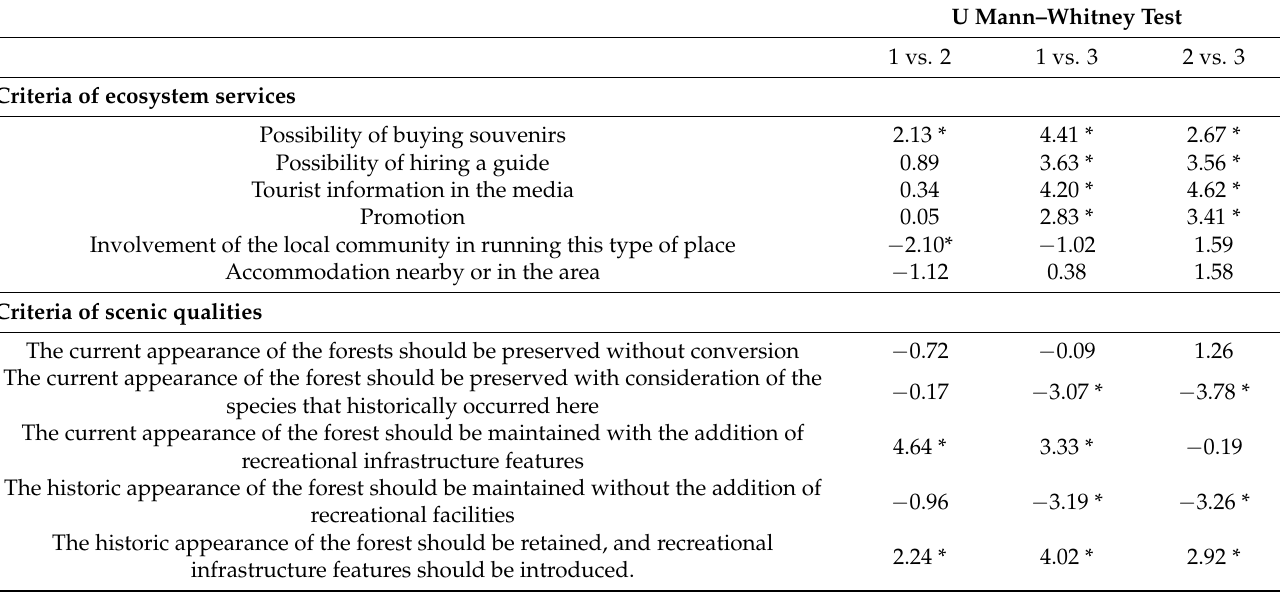
Table 4. Correlation between the selected criteria of ecosystem services and the criteria of scenic qualities by visitor income (U Mann–Whitney test for pairs of income